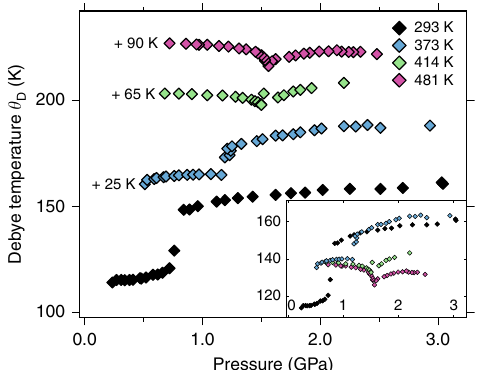
Fig. 6 Debye temperatures of polycrystalline cerium. They are shown versus pressure (uncertainty < 0.05 GPa) at different